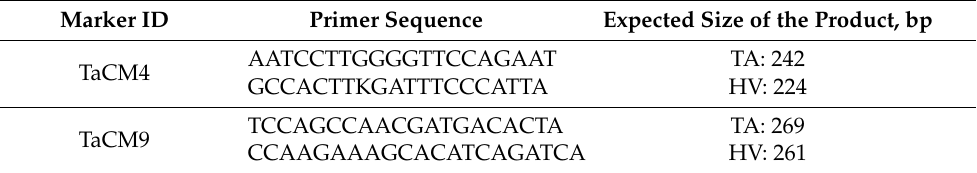
Table 2. Details of the simple sequence repeat markers for the wheat and barley chloroplast genome (TA: T. aestivum ; HV: H. vulgare